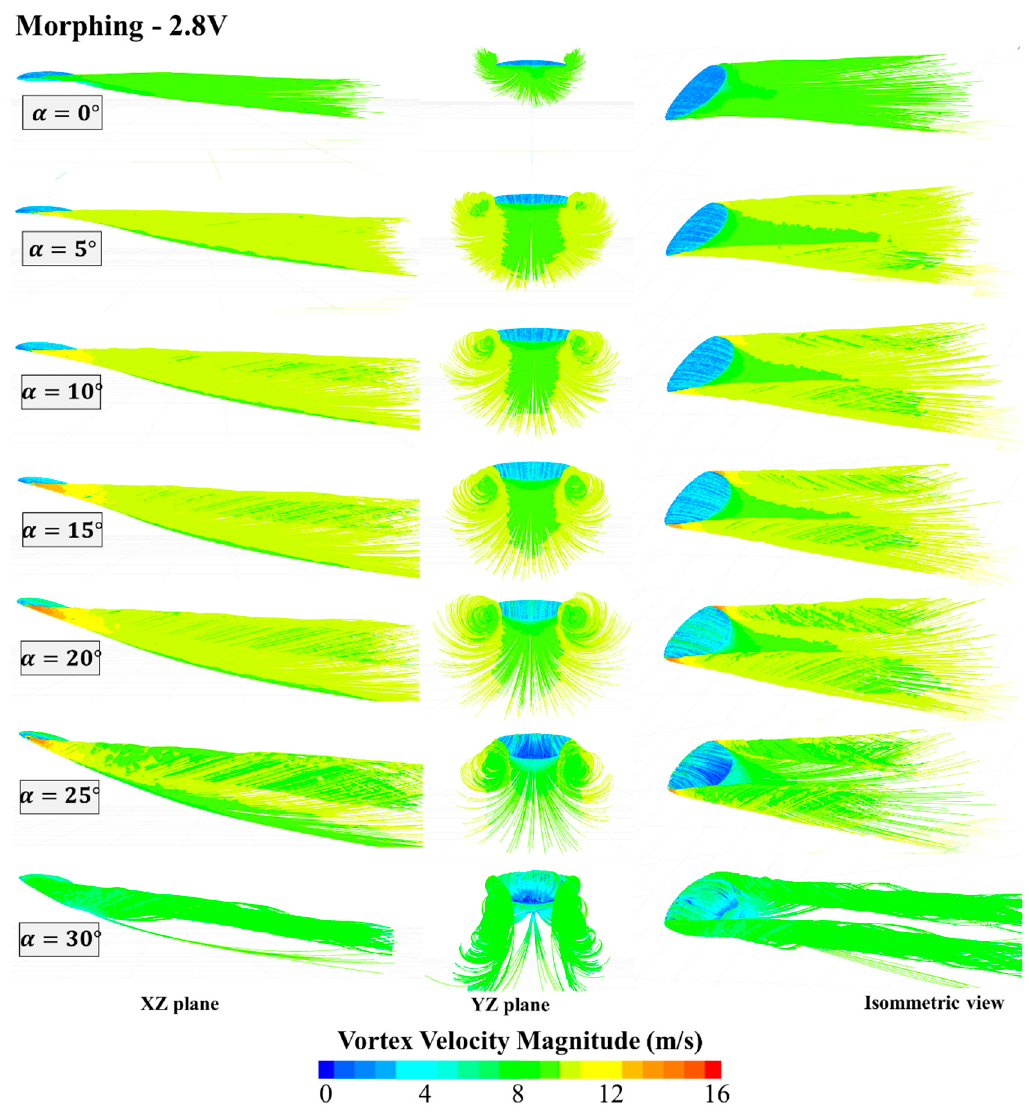
Figure 10. Vortex velocity magnitude for the morphing 2.8 V MAV (semi deformation of the wing) ( U ∞ = 10 m/s, β = 0 ◦ ).